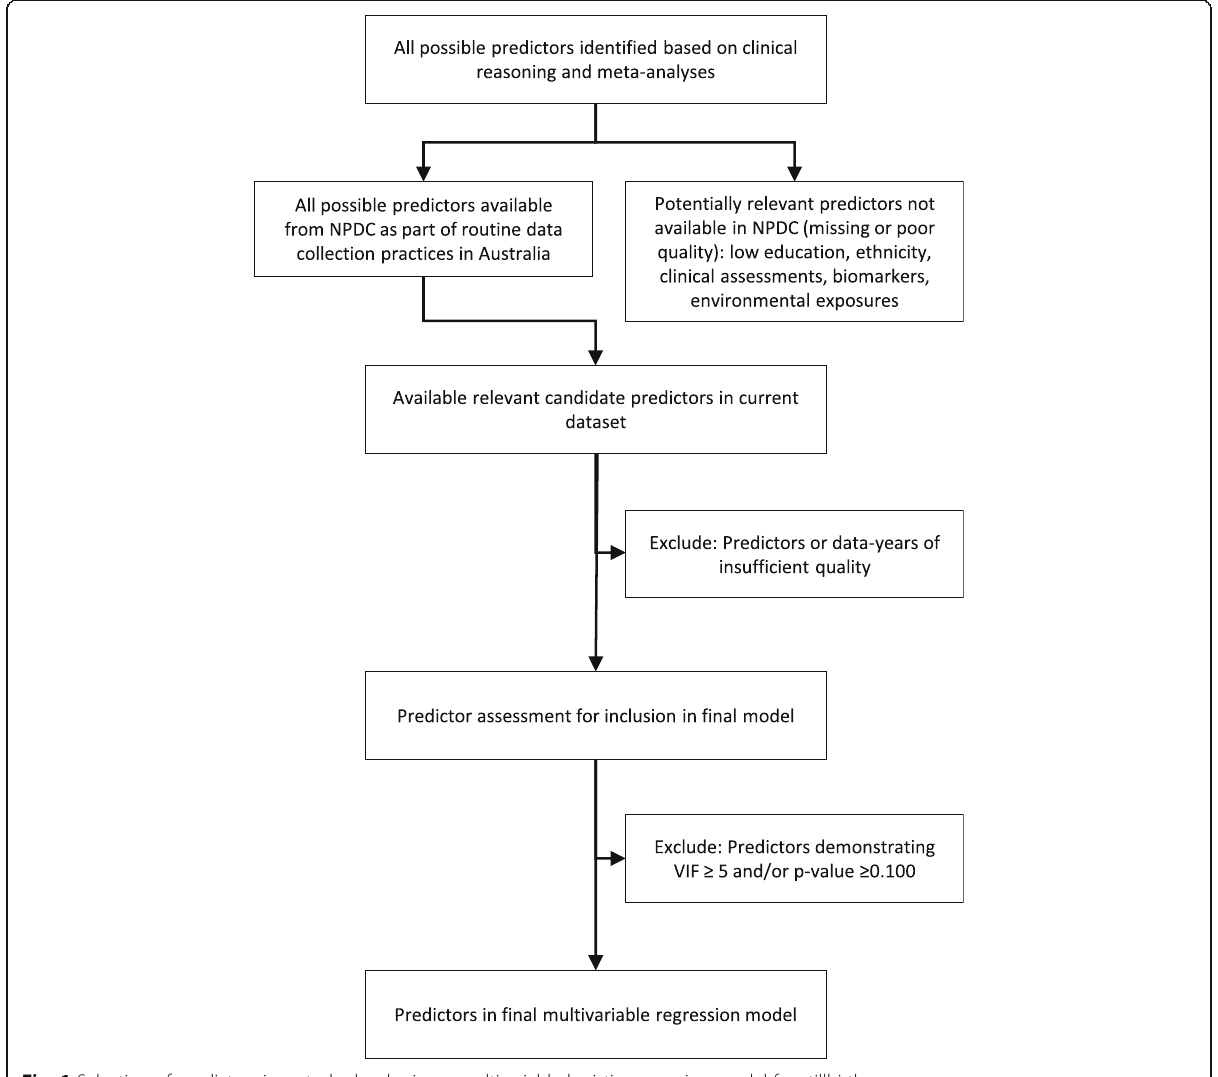
Fig. 1 Selection of predictors in a study developing a multivariable logistic regression model for